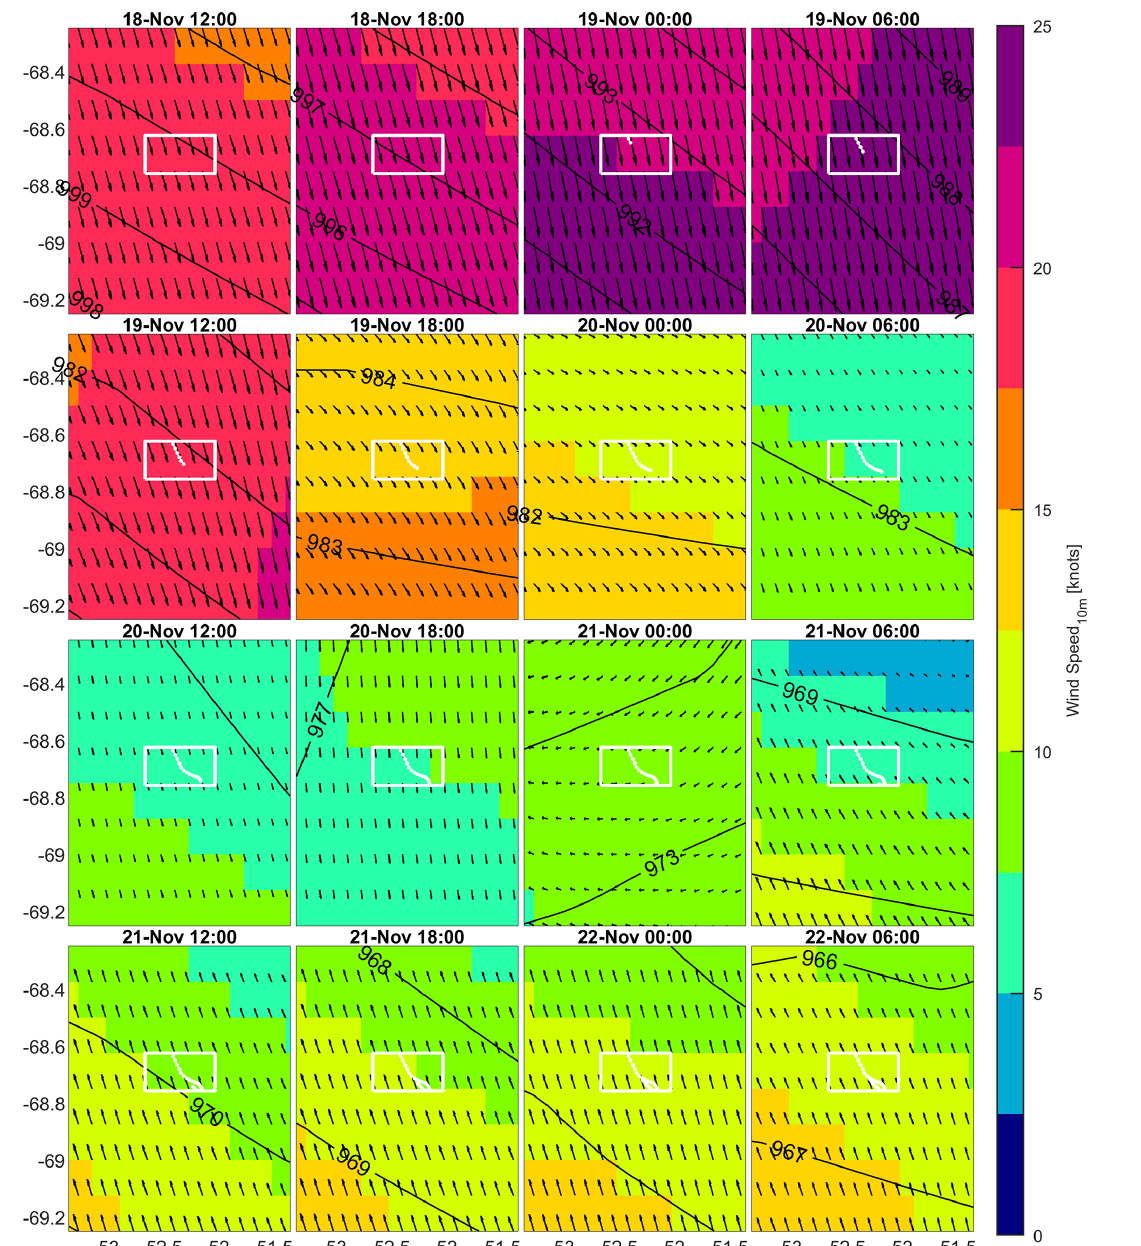
Figure A1. Six-hourly maps of wind speed (colour scale, vector magnitude) and direction (vector orientation) and mean sea level pressure (contours) from ERA-20C. Also shown (white) are the search box and ERA-20C simulated trajectory. All dates refer to 1915.